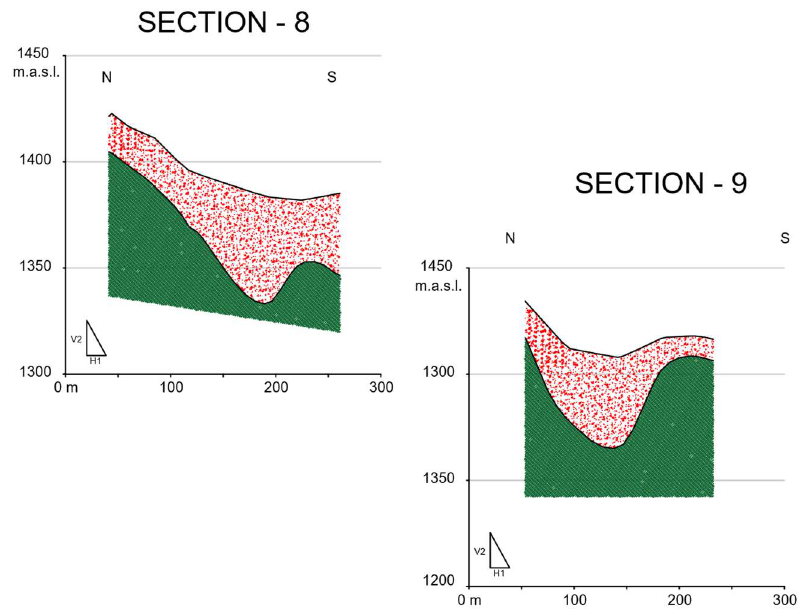
Figure 12. Oblique sections through the north–south direction represent the sliding sediments (in movement) over the basement where the rupture surface geometry is delineated (Drawing Scale relationship: 1H:2V, keeping the vertical relationship of elevation and Figure 10 scale).